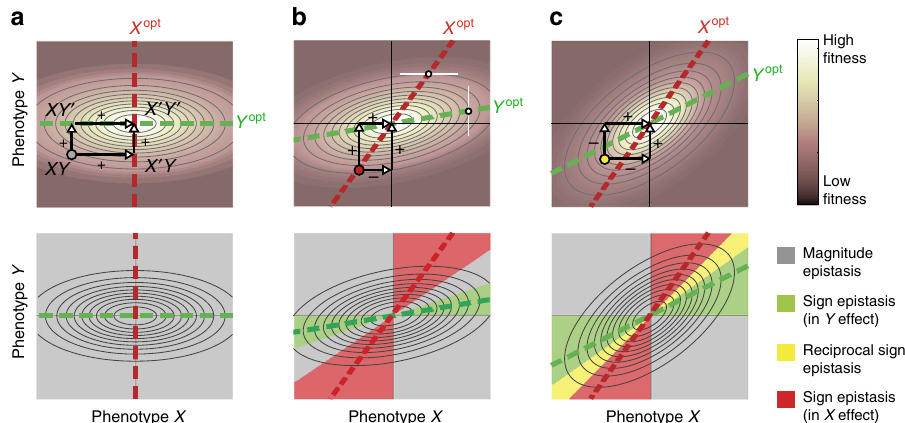
Fig. 2 Sign epistasis resulting from geometric fi tness models. Diagrams illustrating the principles to determine sign epistasis from phenotype – fi tness relations. Here, we consider Gaussian fi tness functions that do not speci fi cally describe cascades nor molecular interactions. a Non-rotated Gaussian fi tness function indicated by colour gradient and elliptical iso- fi tness lines. Importantly, we consider mutations that affect X but not Y , and mutations that affect Y but not X , which is typically the case if X and Y have a distinct genetic basis. Mutations in X and Y are therefore described by orthogonal vectors (arrows). We consider mutations that lead from a suboptimal phenotype XY to the optimal X ′ Y ′ (arrows). For any starting phenotype XY in this landscape, all four mutations to X ′ Y' produce increase in fi tness, resulting in magnitude epistasis (grey) everywhere (bottom). b Rotated Gaussian fi tness function (angle = π /12). Starting from the red dot phenotype, one mutation decreases fi tness, which implies sign epistasis (see arrows). To understand in mathematical terms, consider the dashed red line ( X opt ), which indicates where the tangent of the iso- fi tness lines is horizontal (white horizontal line). When moving along this tangent (which changes X but not Y ), the fi tness is optimal at X opt . Thus, starting at or around X opt , when changing X but not Y , fi tness can only decrease. When the line X opt is non-vertical as here, the same mutation can increase fi tness in another Y background ( Y ’ ), because the optimum then shifts, and hence the phenotype ( XY ’ ) no longer lies at the optimum. The same analysis holds for the green dashed line ( Y opt ). c Rotated Gaussian fi tness function (angle = π /4). When domains for sign epistasis in X- and Y -effect (red and green) overlap, one obtains reciprocal sign epistasis (yellow dot). To link these features, such as the degree of rotation or skewness to the molecular level, one can consider a mechanistic fi tness